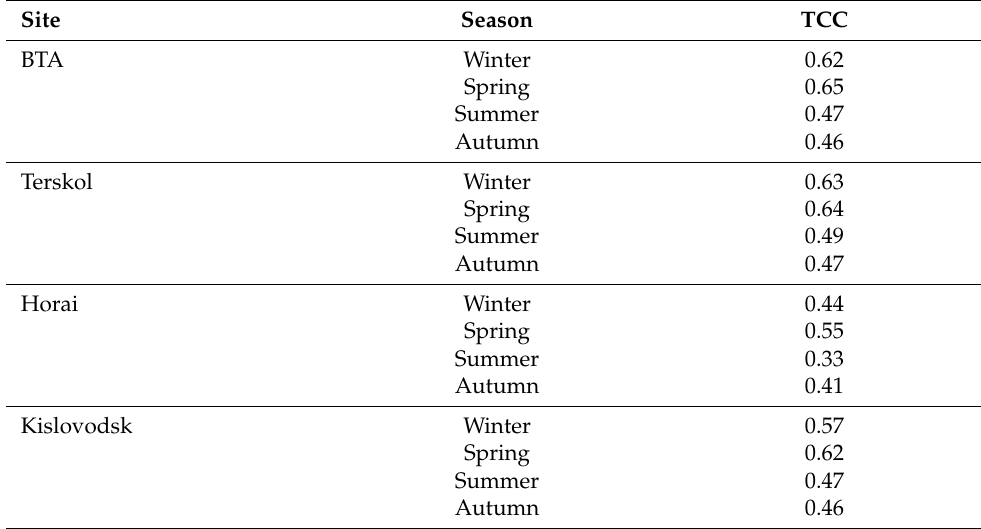
Figure 7. Spatial distributions of total cloud cover within the BTA region obtained for the period 2010–2020: ( a ) winter; ( b ) spring; ( c ) summer; ( d ) autumn. Table 3. Mean values TCC at the sites suitable for mm/submm